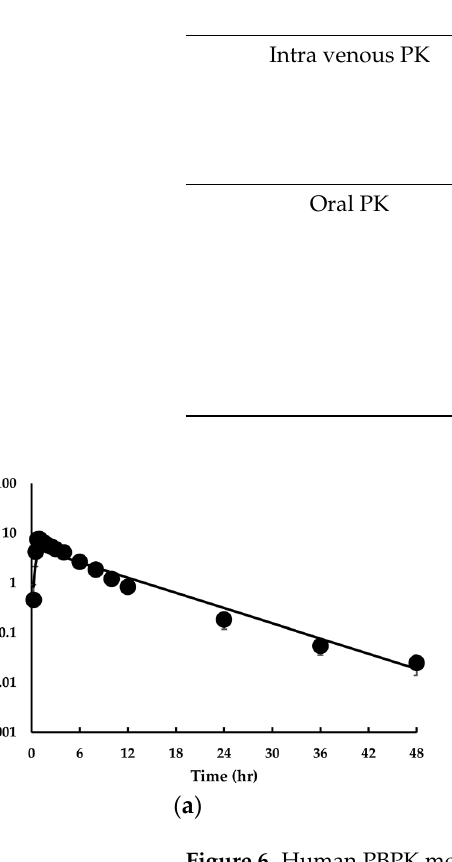
Table 5. Observed and predicted PK parameters of IDP-73152 in dogs.